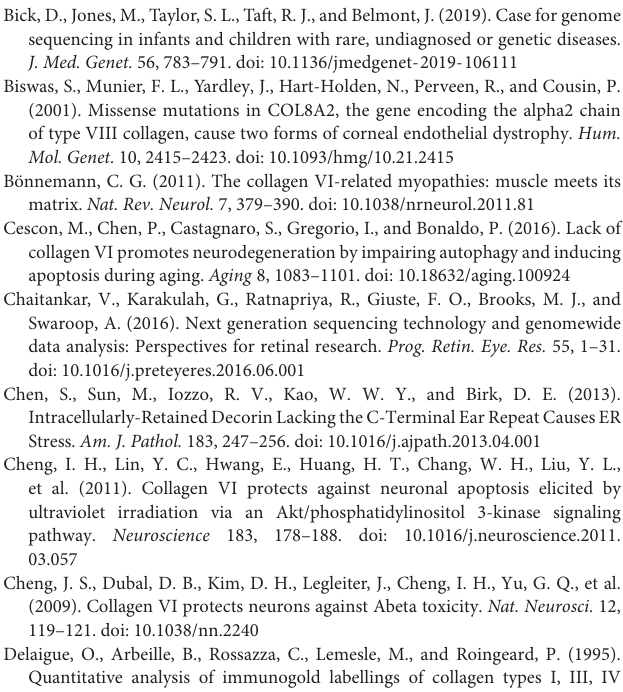
Supplementary Table 1 | Variants identified by whole-exome sequencing. Supplementary Table 2 | Primers used in